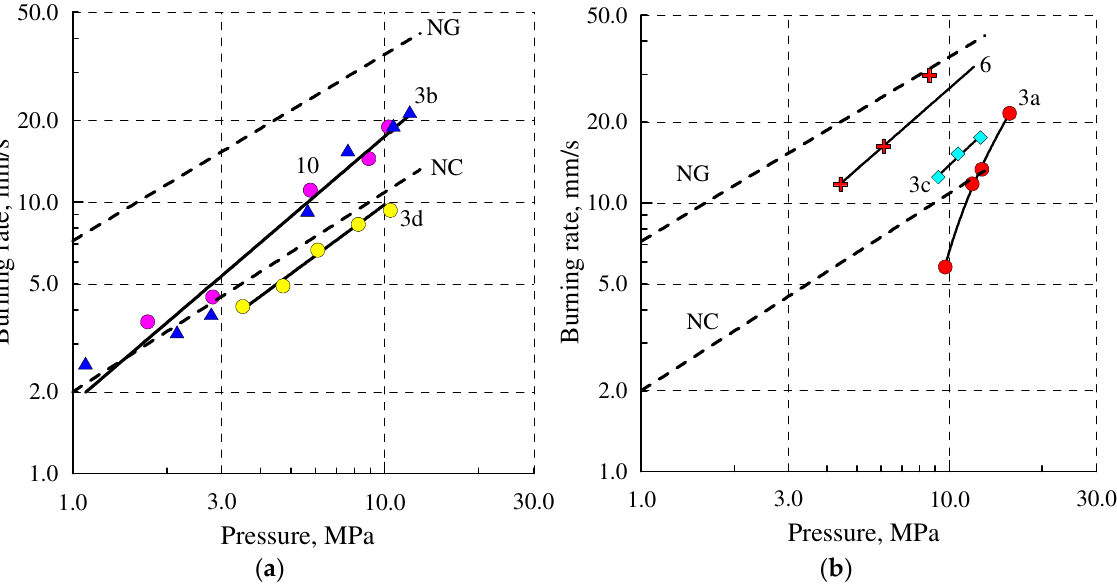
Figure 5. ( a ) Comparison of the burning rates of azides 3b , 3d and 10 with NG and NC ; ( b ) Comparison of the burning rates of azides 3a , 3c and 6 with NG and NC .